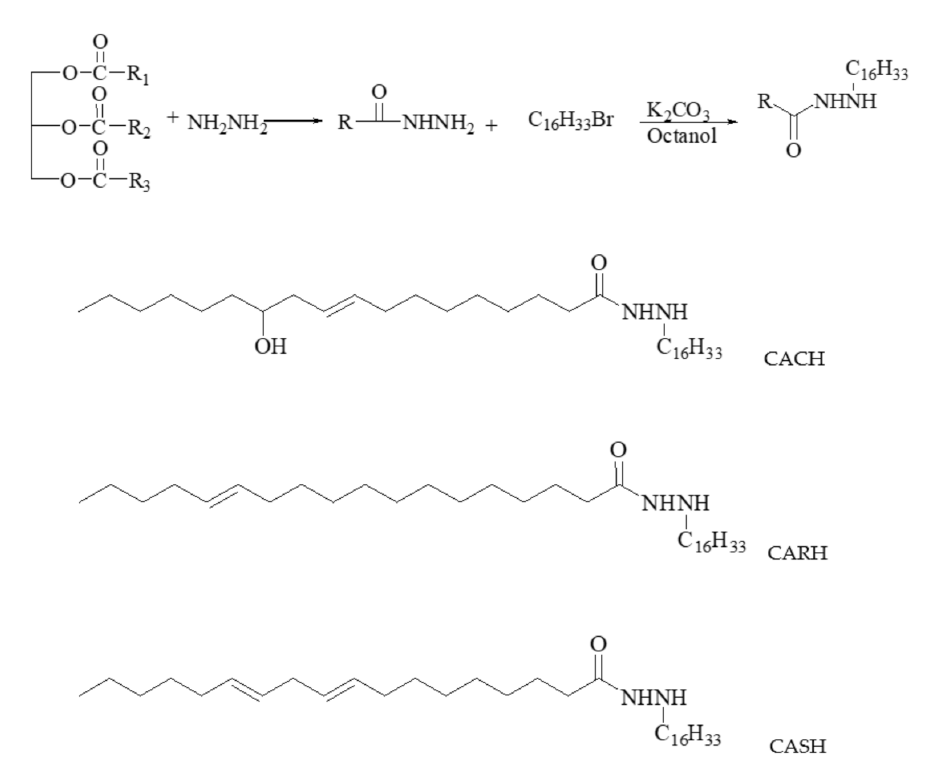
Figure 1. Synthesis and the main products of the three long-chain aliphatic